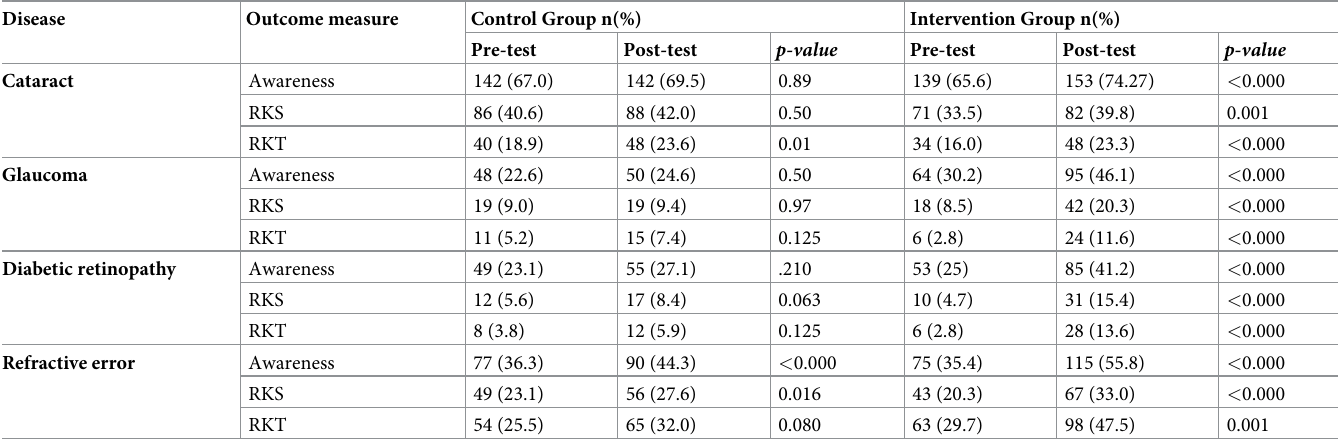
Table 2. Changes in EHL (awareness and knowledge) scores between the pre-and post-test assessment between the two groups. Disease Outcome